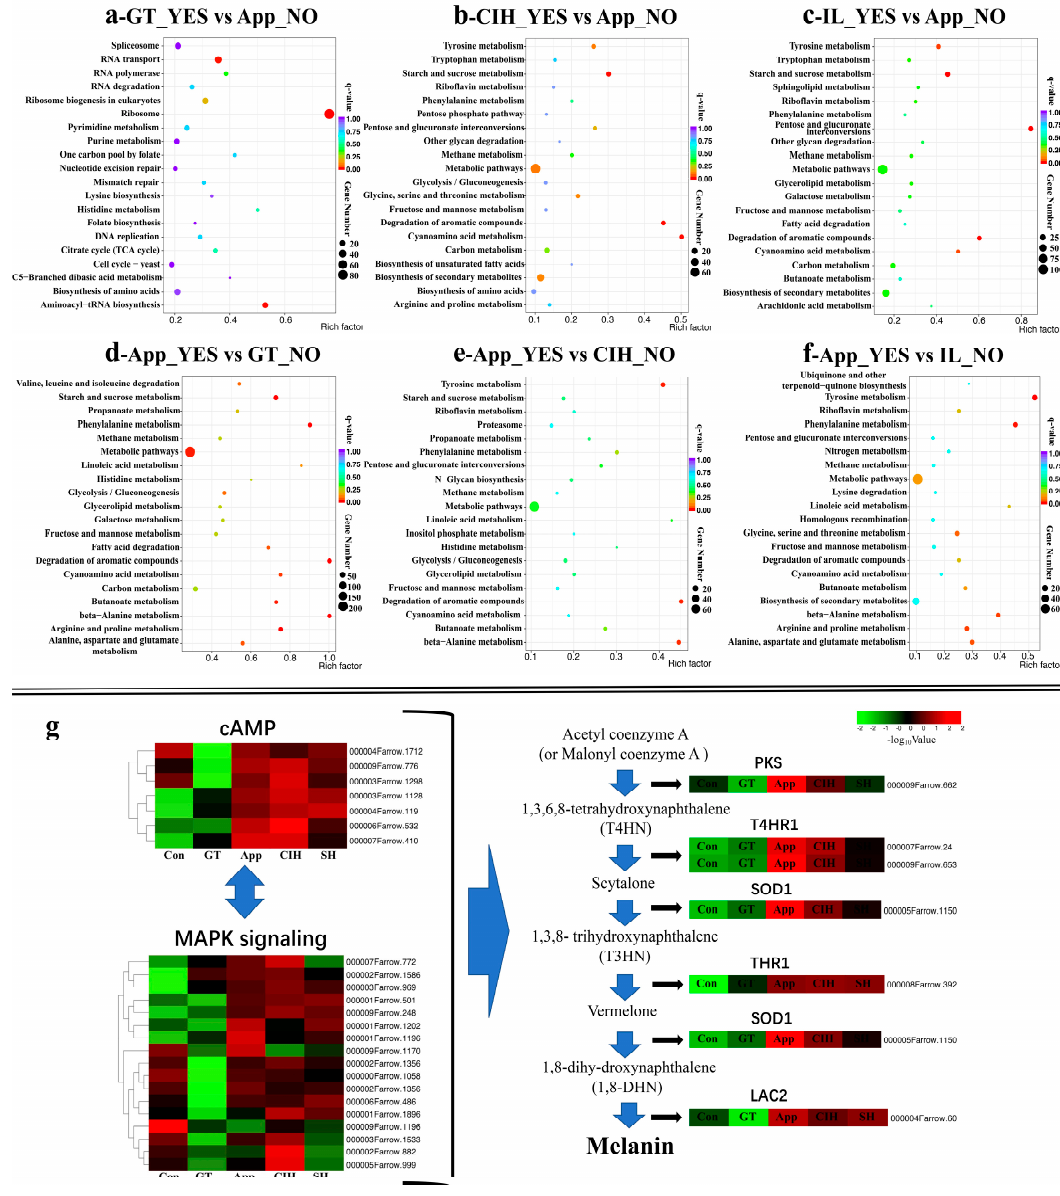
Figure 5. Kyoto Encyclopedia of Genes and Genomes (KEGG) analysis of up-DEGs (di ff erentially expressed genes) in the GT / App, CIH / App and IL / App groups and expression patterns of melanin biosynthesis related genes. ( a – f ). KEGG analysis of specific up-regulated DEGs in di ff erent comparable groups of C. camelliae . ( g ) Heat map of relevant melanin biosynthesis genes of C. camelliae ; the expression was based on the FPKM (Fragments Per Kilobase of transcript sequence per Millions base pairs sequenced) value. Color scale was provided for two figures. (cAMP: cyclic adenosine monophosphate; MAPK: mitogen-activated protein kinase; Con: conidium; GT: germ tube; App: appressoria; CIH: cellophane infectious hyphae; IL: infection leaves; PKS : Polyketide synthase ; T4HR1 : 1,3,6,8-tetrahydroxynaphthalene reductase 1 ; SOD1 : Scytalone dehydratase 1 ; THR1 : 1,3,8-trihydroxynaphthalene reductase 1 ; LAC2 : Laccase gene 2